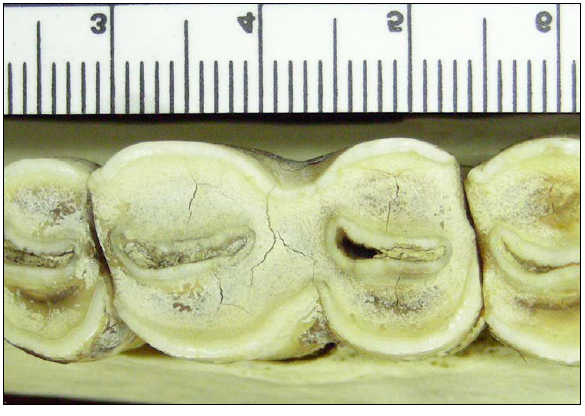
Figure 5: AZ 1576, a mandibular second molar from a Hippotragini, Oryx gazella (gemsbok), that was classified as an Alcelaphini, Alcelaphus buselaphus (hartebeest). Taking into consideration that wear remains an issue, the method presented here could assist in mitigating the challenge of taxonomically identifying worn bovid teeth. Valuable information – such as the number of individual specimens, minimum number of individuals and relative abundance of taxa – is lost when teeth in an assemblage are grouped into broad taxonomic levels due to their poor preservation. It is important to keep in mind that most bovid teeth in the fossil record are isolated. The classifications of the teeth in this study are known because they are complete dentitions in the maxilla/mandible, associated with horn cores and housed in museum collections. In the absence of such a context, teeth are especially difficult to identify. This program, however, provides a supplement to the identification of bovid teeth where ambiguity